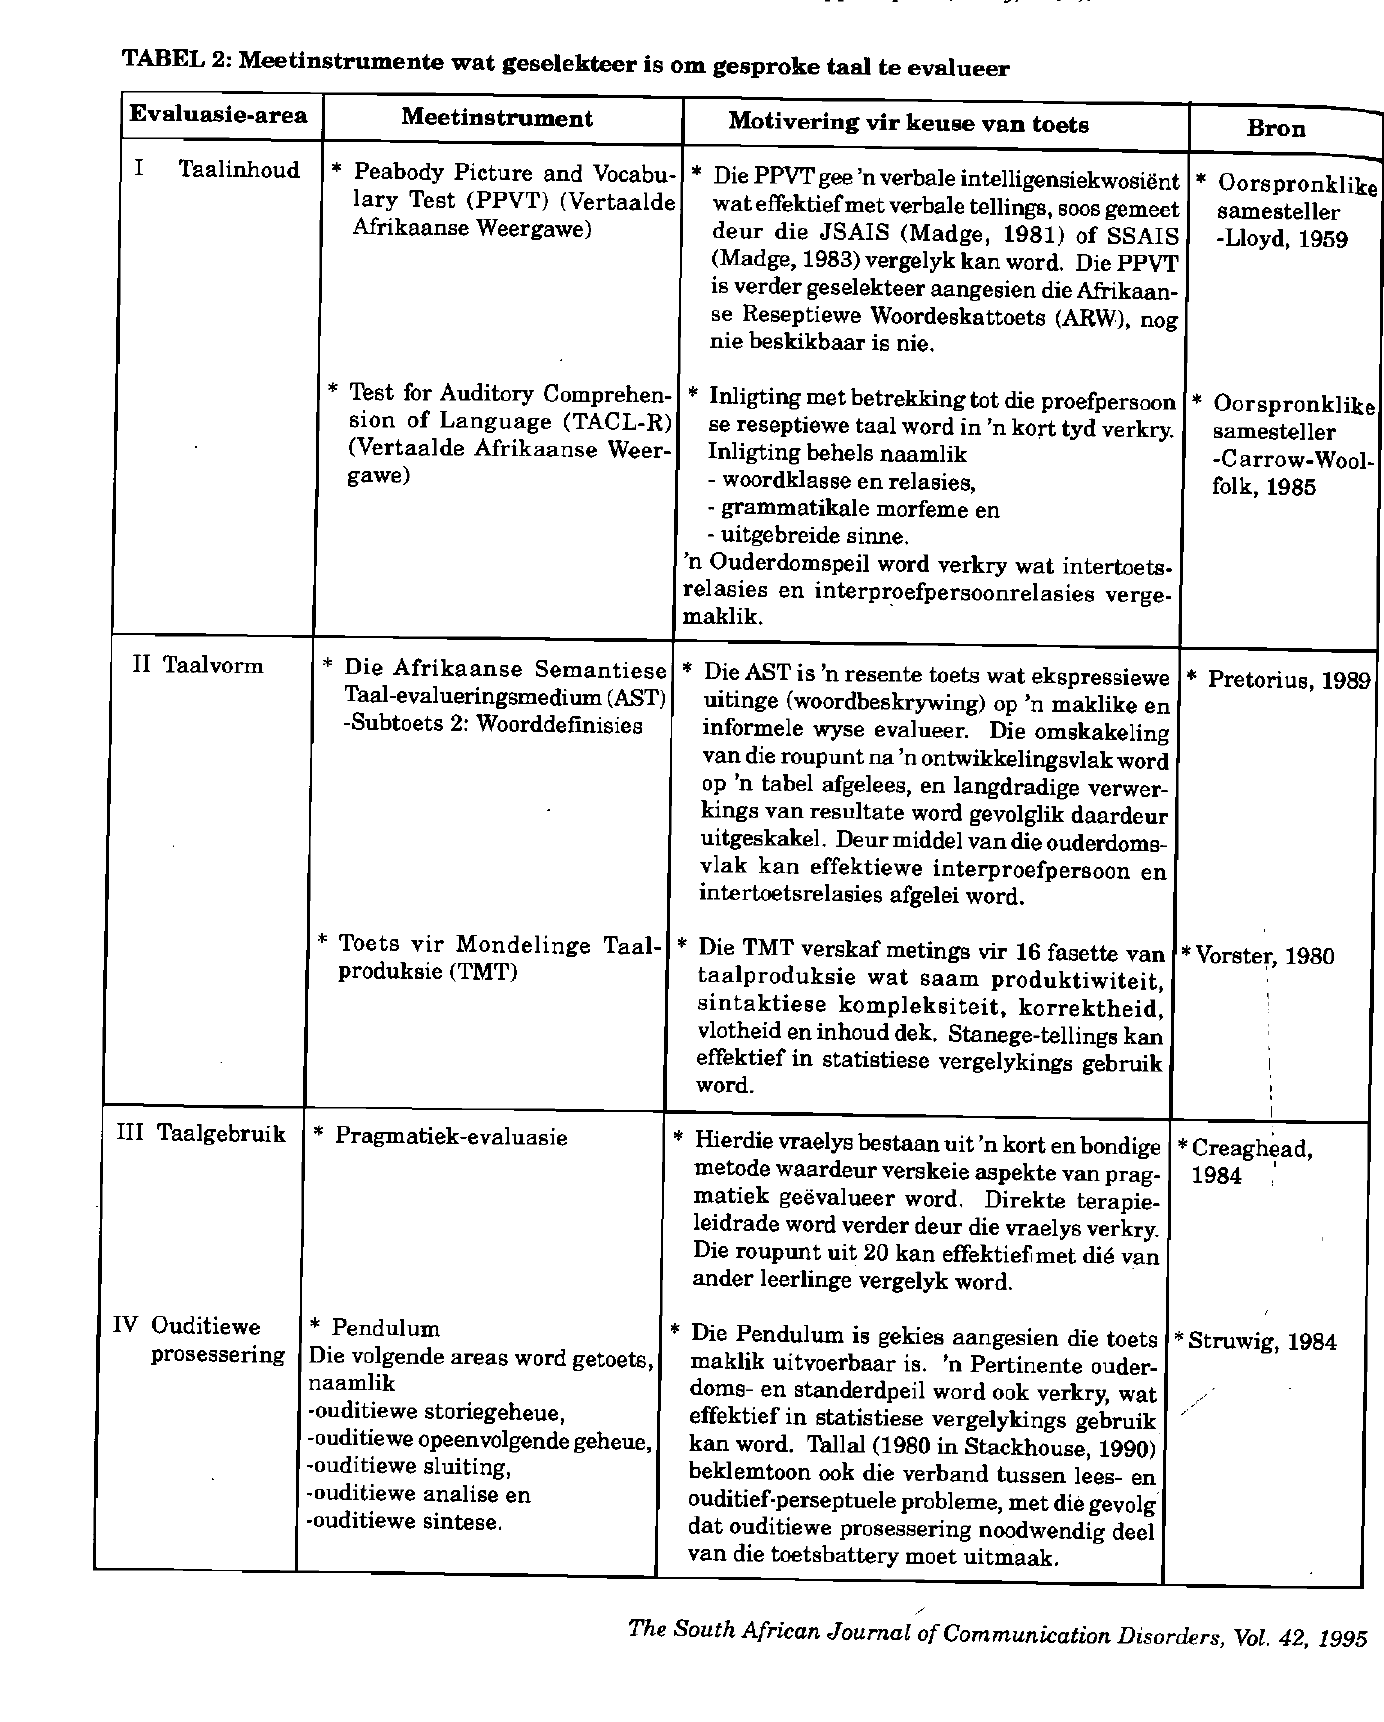
- Proefpersone is aan spraak-taalterapeute en 'n remedierende onderwyseres toegeken vir uitvoering van diagnostiese toetsing. Spesifieke voorskrifte is gevolg ten opsigte van uitvoering van toetse. - Akkurate beskrywing van data is op gefotostateerde vorms aangeteken.